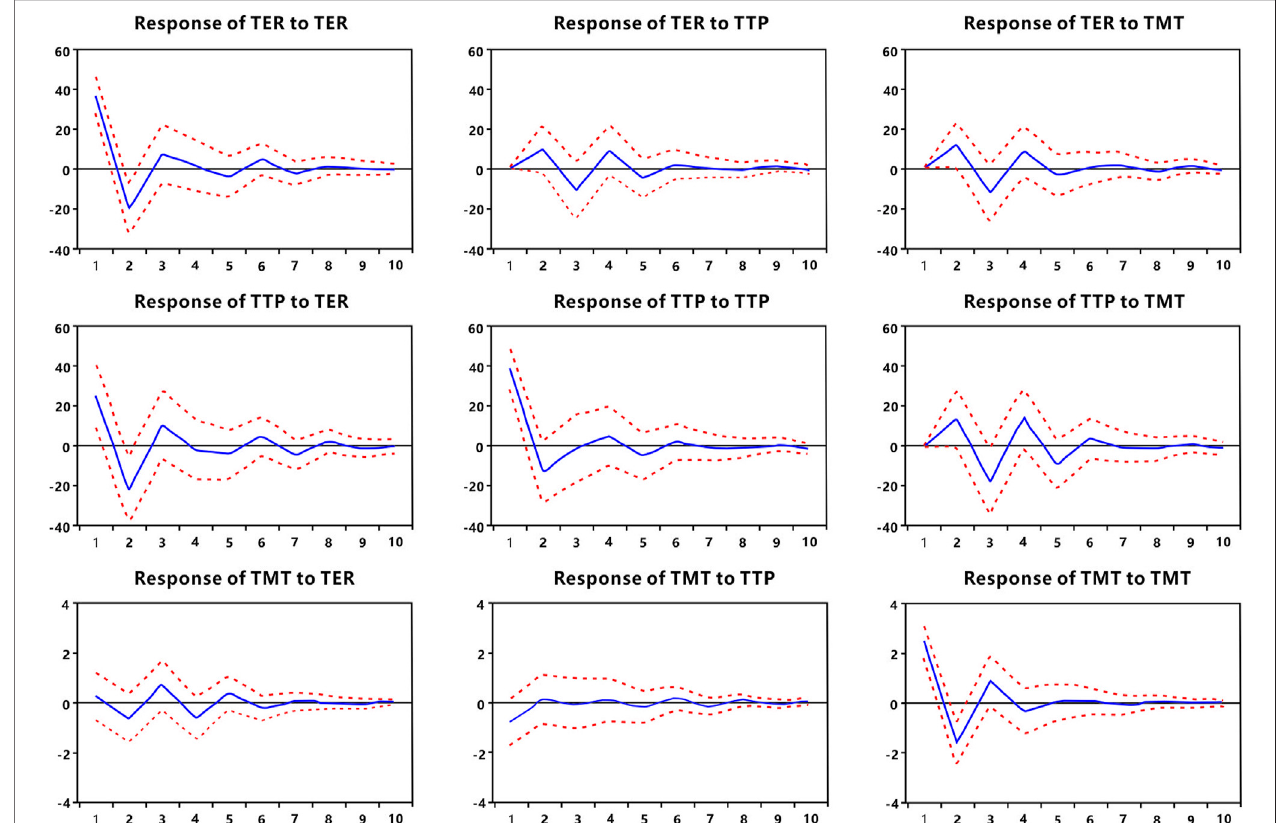
FIGURE 5 | Impulse responses of TER, TTP, and